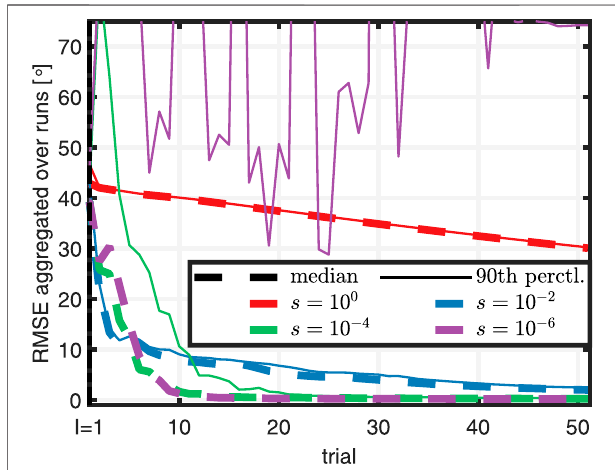
FIGURE 10 | Investigation of the effect of weight s on the learning characteristics: Large values of s lead to slow learning with smallperformance variance.Increasingthevalueleadstofasterlearningbutalsoalargervariance in performance. Excessively small values of s may lead to a RMSE that diverges for some initial